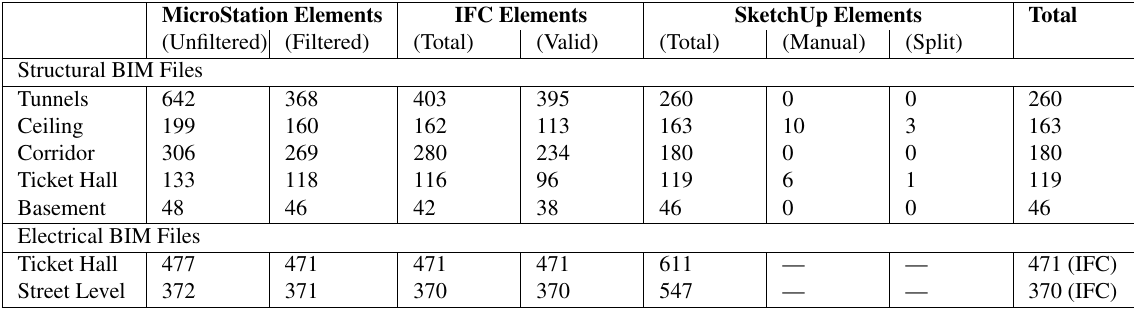
Table 3. Export, transformation and loading of MicroStation Elements via IFC and SketchUp to GIS